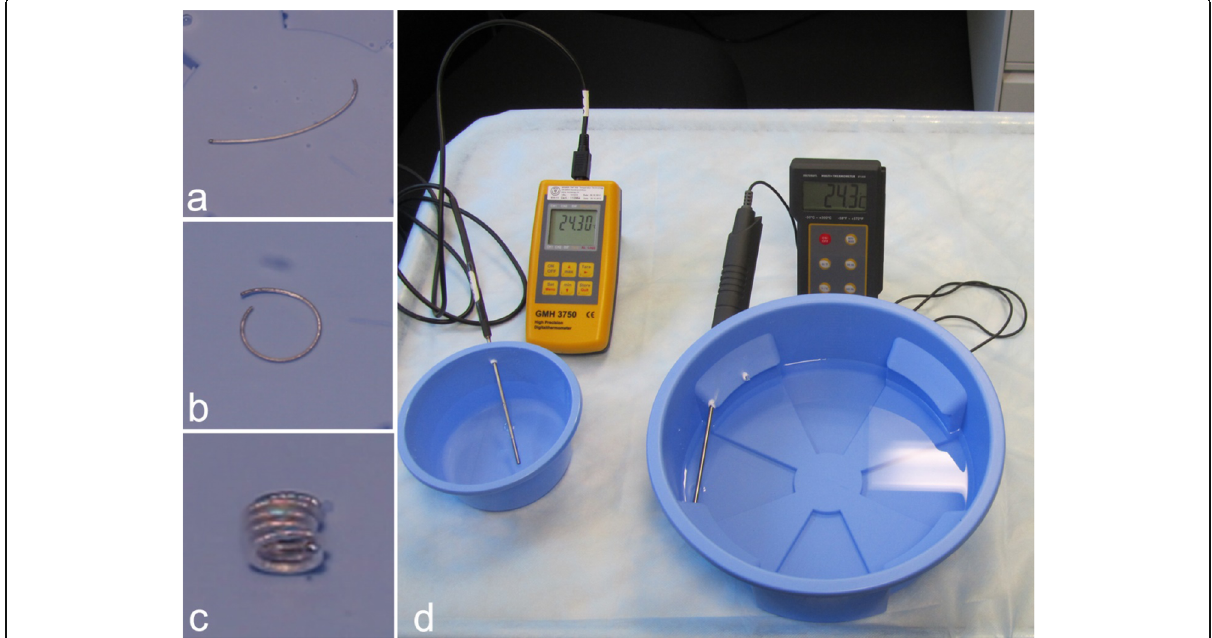
Fig. 1 Classification of HydroCoil configurational changes: Configuration I, minimal curvature of the HydroCoil without reaching a first loop ( a ); Configuration II, first complete loop without complete curling of the HydroCoil ( b ); Configuration III, complete HydroCoil curling ( c ). d shows two different experimental open-fluid immersion chambers with their respective digital thermometer systems (the external thermostat and chronometers are not